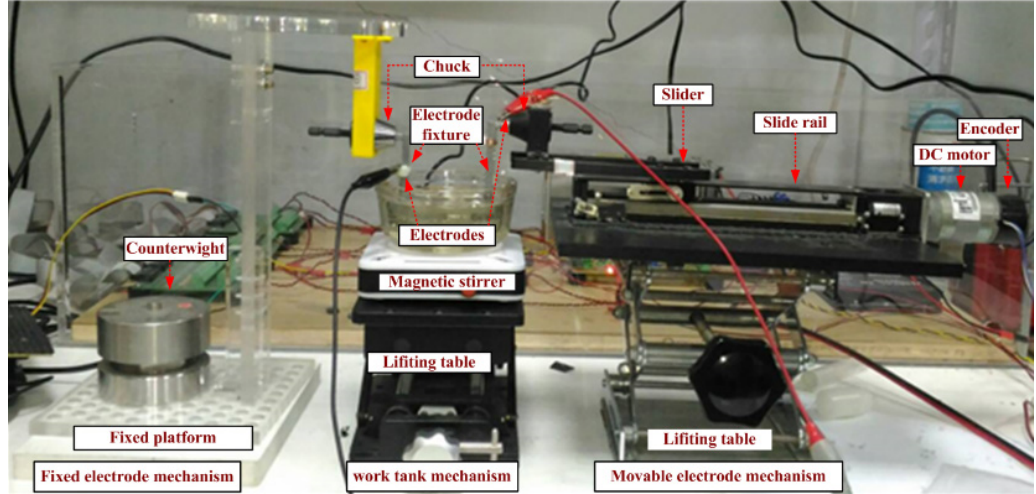
Figure 3. Production mechanism in the micro-EDM system.